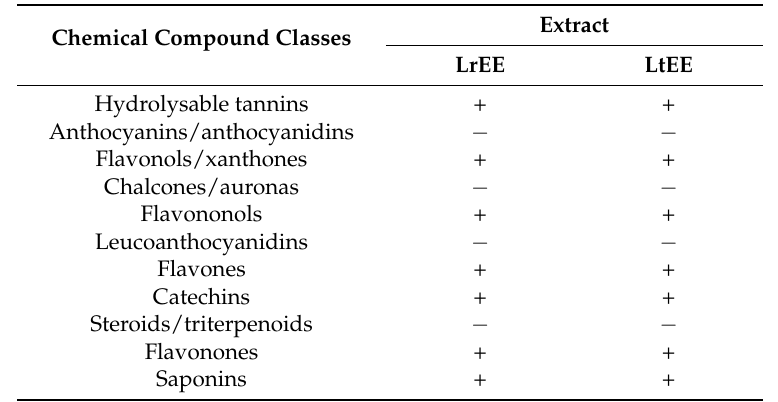
Table 1. Phytochemical screening of chemical compound classes in the ethanolic extracts of Licania rigida and L. tomentosa